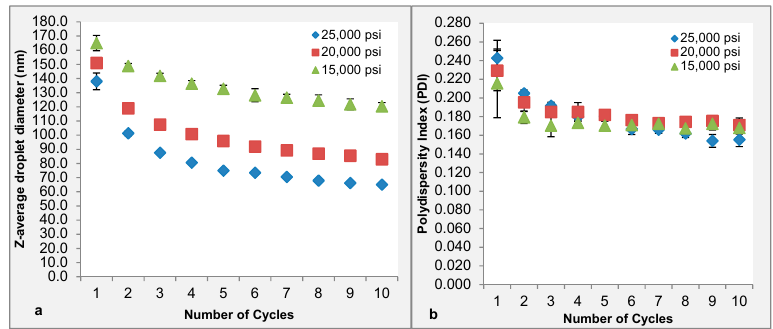
Figure 1. Influence of operating pressure and number of cycles on mean droplet diameter ( a ) and polydispersity index (PDI) ( b ) of tocotrienol rich fraction (TRF) nanoemulsions prepared with emulsifier blend Span 80:Brij 35 (0.4:0.6 w / w ) at a concentration of 2.5% w / v .